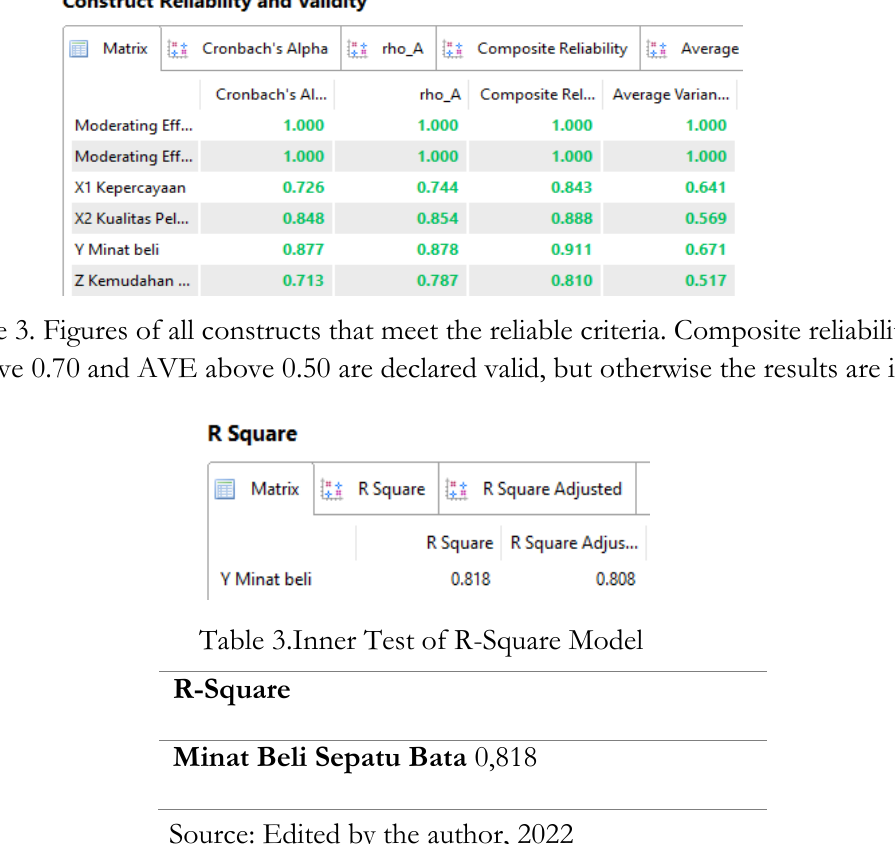
Source: Edited by the author,